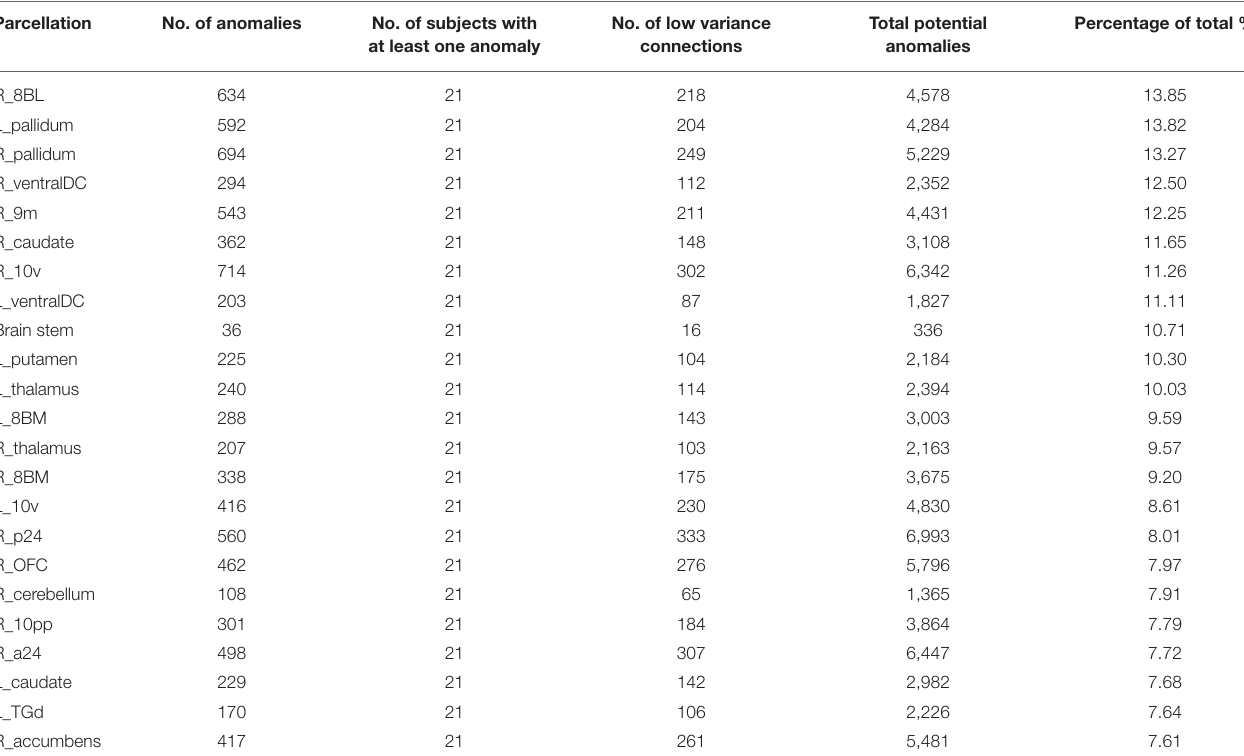
TABLE 2 | Structural anomaly